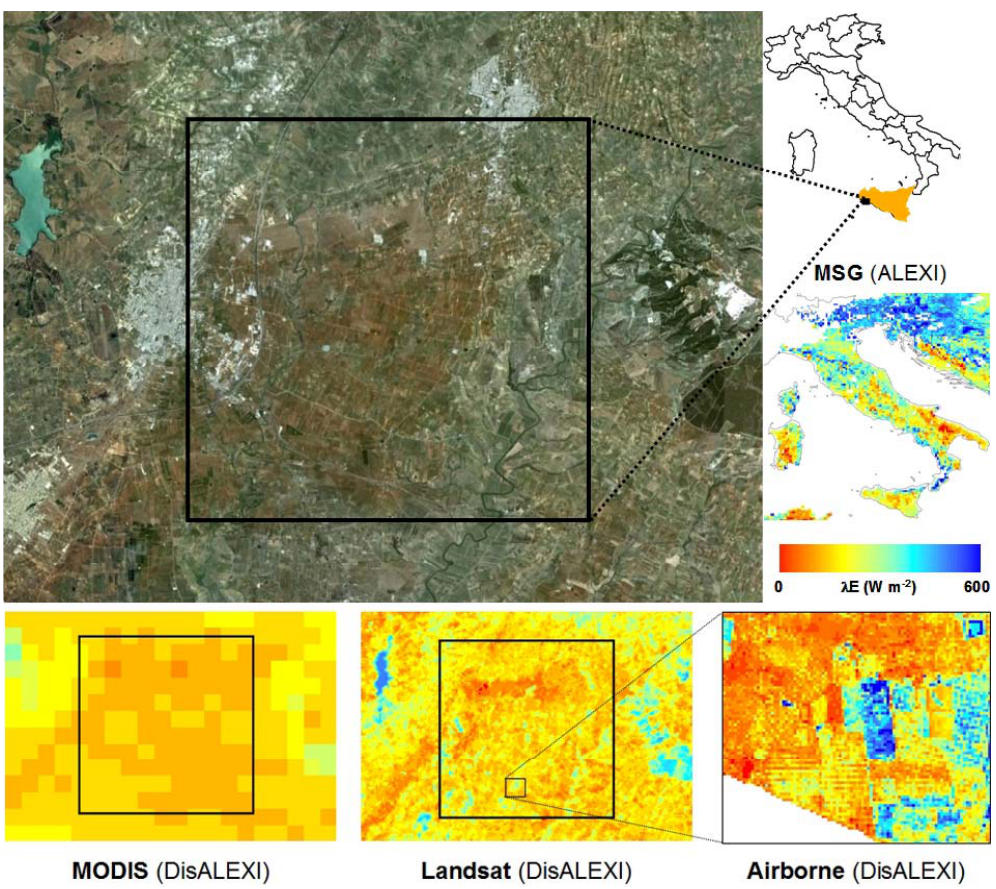
Fig. 9. Multi-scale clear-sky latent heat flux maps (shortly before noon) produced for 22 July 2008 with ALEXI/DisALEXI using surface temperature data from MSG (10-km), MODIS (1-km), Landsat (60-m) and aircraft (10-m resolution). Black boxes on the orthophoto (top), MODIS and Landsat images highlight an MSG pixel size, while the airborne image shows the Castelvetrano (Sicily) experimental site in the Belice